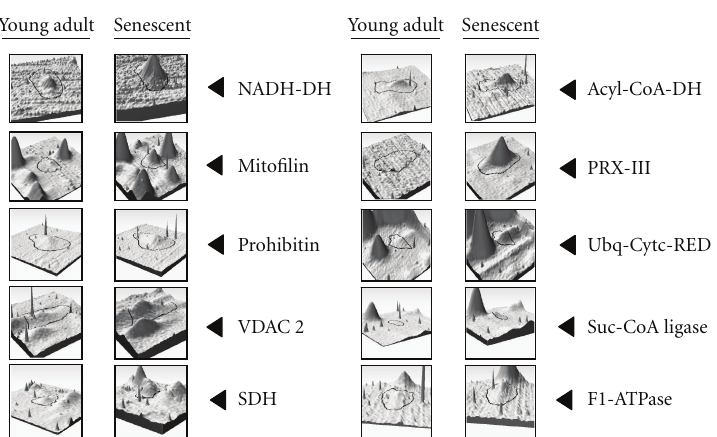
Figure 3: Proteomic profiling of the mitochondria-enriched fraction from aged skeletal muscle tissue. Shown is the comparative graphic representation of distinct two-dimensional protein spots with a changed expression in aged muscle as judged by fluorescence di ff erence in-gel electrophoretic analysis [97]. Individual panels document alterations in the abundance of NADH dehydrogenase (NADH-DH), the inner mitochondrial membrane protein mitofilin, prohibitin, the porin isoform VDAC 2, succinate dehydrogenase (SDH), acyl-coenzyme A dehydrogenase (Acyl-CoA-DH), peroxiredoxin isoform PRX-III, ubiquinol-cytochrome c reductase core I protein (Ubq-Cytc-RED), succinate-coenzyme A (Suc-CoA) ligase, and mitochondrial